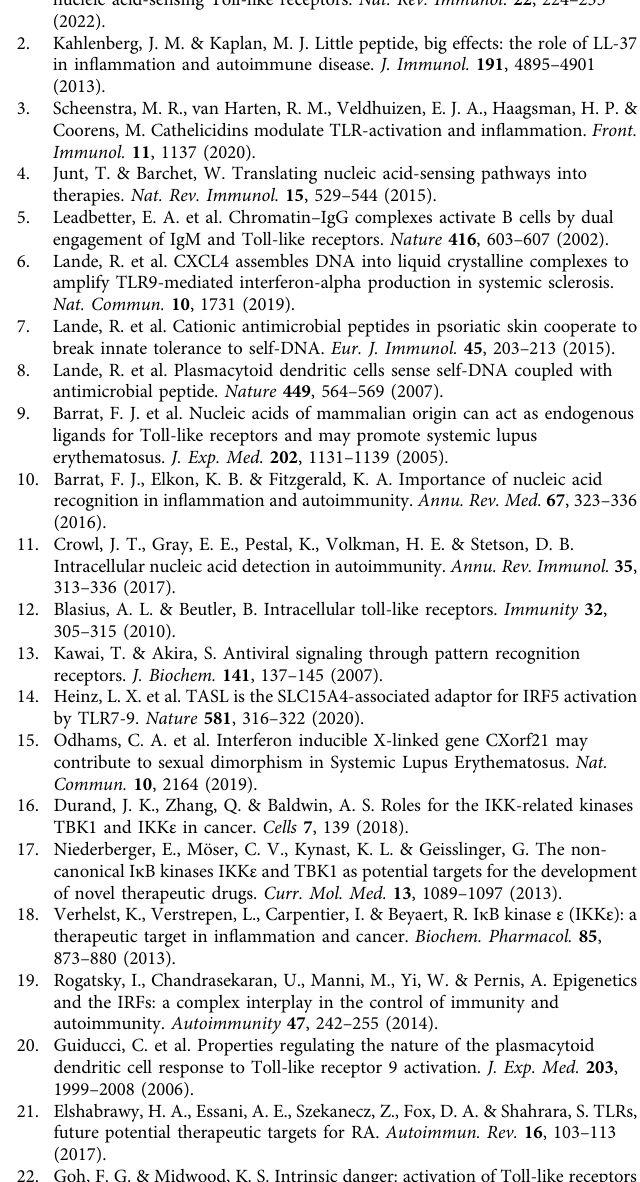
(listed in Supplementary Table 1) using a Human Monocyte Nucleofactor Kit (Lonza, VVPA-1007) and the AMAXA Nucleofector System (Lonza) program Y001 for human monocyte transfection according to the manufacturer ’ s